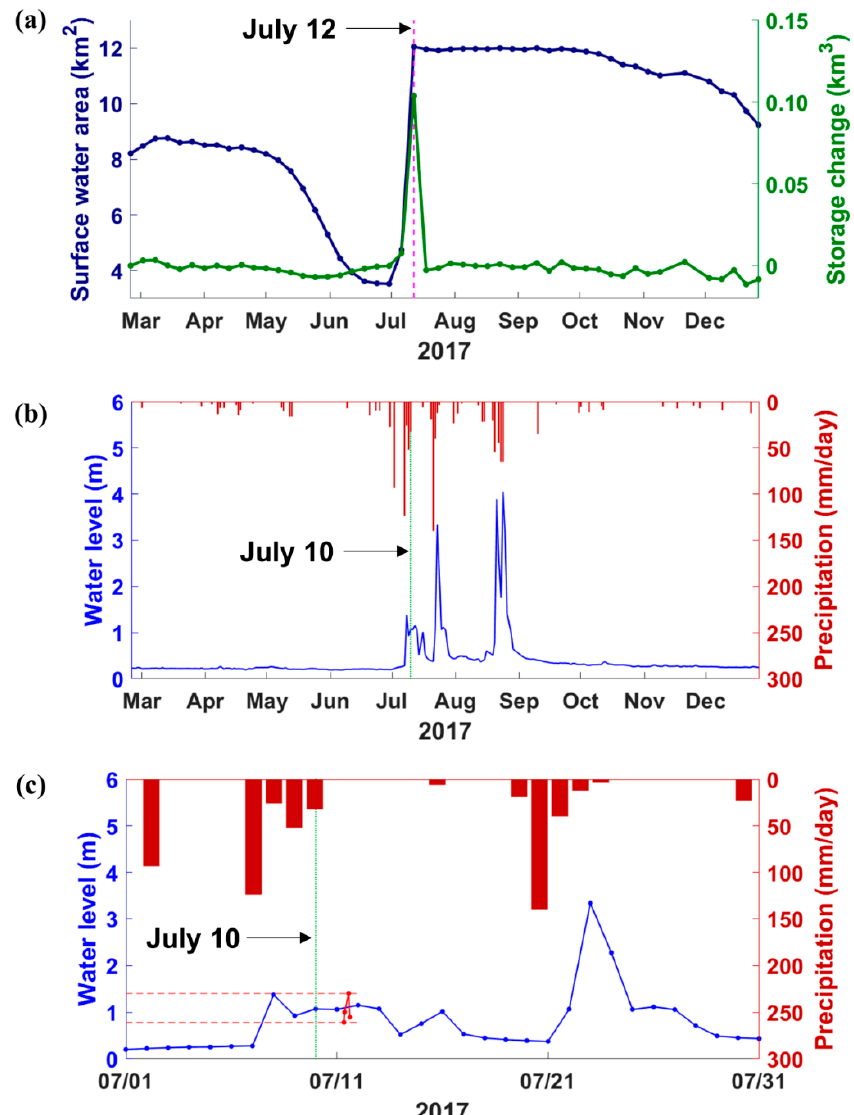
Figure 12. ( a ) Surface water areas and storage changes of the Hwanggang Reservoir in 2017, ( b ) daily mean water levels at the Hoengsan station and daily precipitation measurements obtained from CHIRPS in 2017, and ( c ) daily mean water levels at the Hoengsan station and daily precipitation measurements obtained from CHIRPS in July 2017. The purple line in Figure 12a indicates the date, 12 July 2017. The green lines in Figure 12b,c indicate the date, 10 July 2017. The red dots in Figure 12c represent sub-daily data based on YTN news on 11 July 2017 [54].